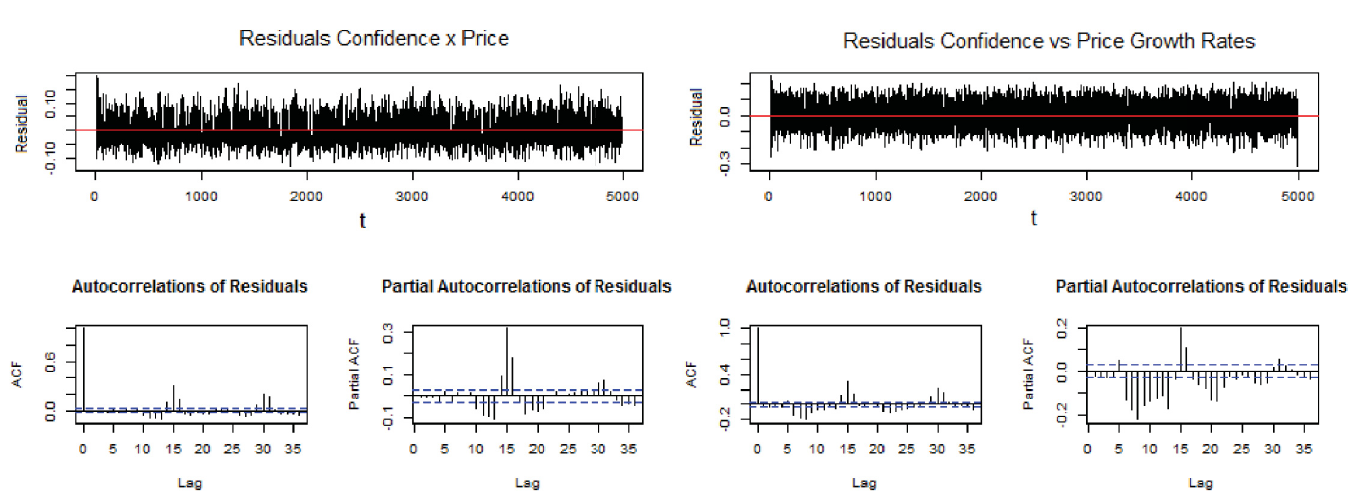
Fig 10. Autocorrelation function of residuals from the regressions (on the left) “confidence vs price” and (on the right) “confidence vs price” formulas. Source: Own creation.